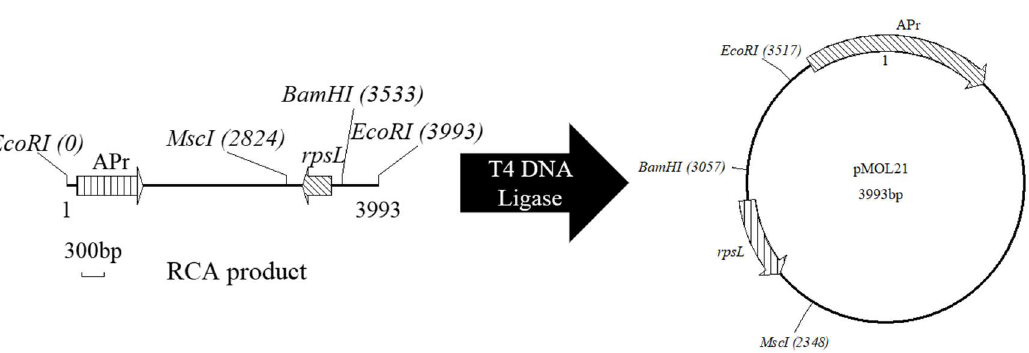
Figure 2. Flow chart of the treatment of RCA products.